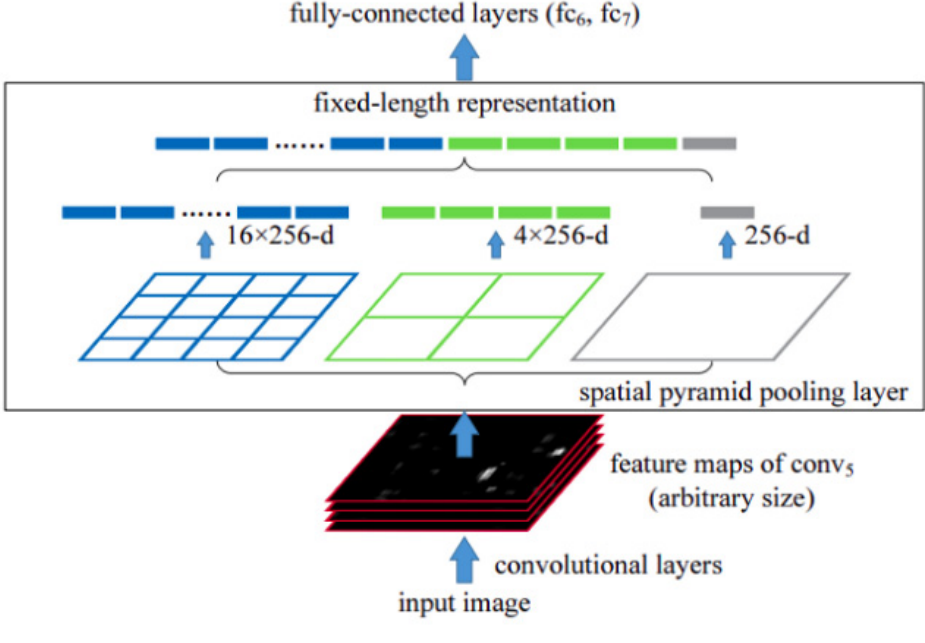
Figure 3. SPP NW Framework.